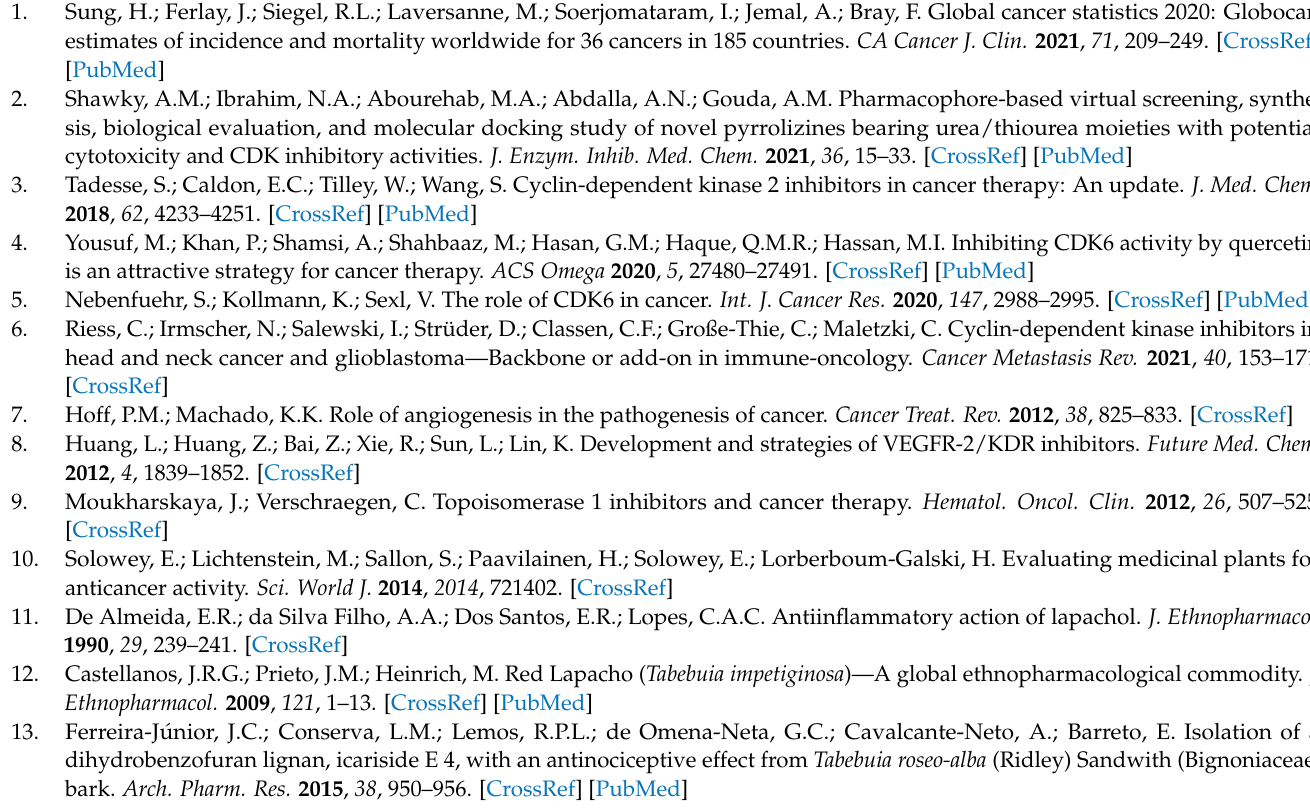
Table S5: the ADMET analysis of compounds 2 , 4 – 9 , 11 , and 12 ; and Table S6: the ADMET analysis of compounds 13 – 15